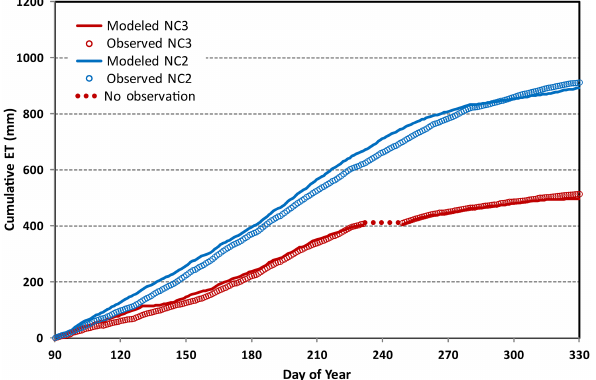
Figure 9. Comparison between the modeled and observed seasonal cumulative ET at NC2 and NC3 during 2013.